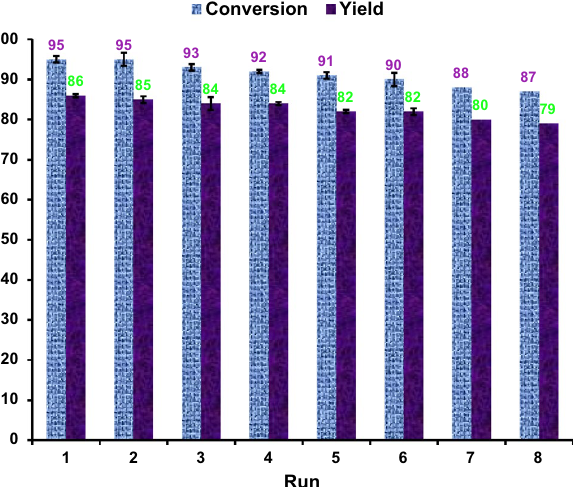
Figure 3. Recycling of the A-CQDs/W catalyst in oxidative cleavage of coumarin-3-carboxylic